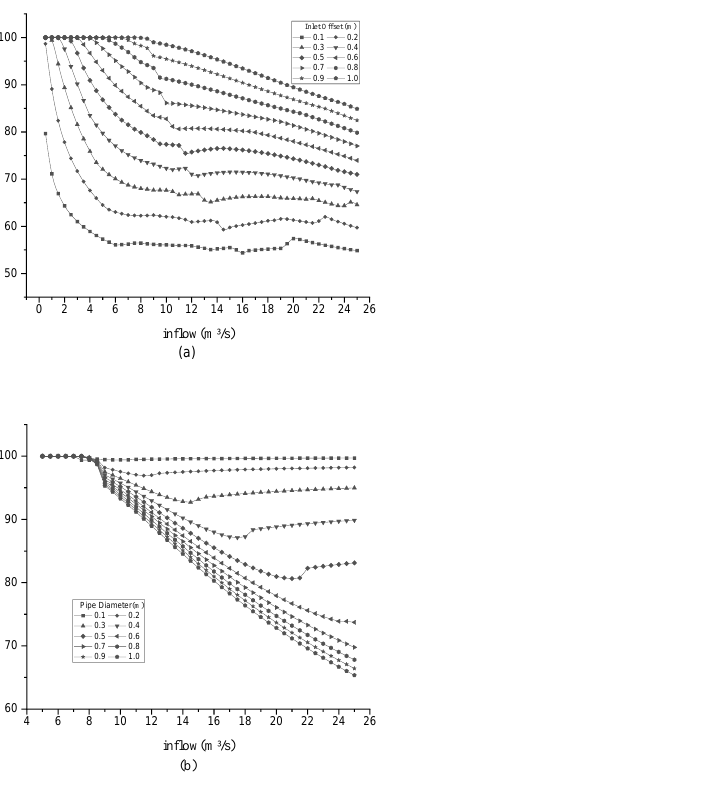
Figure 5. ( a ) Two pipelines with a diameter of 1 m. The inlet offset of one bifurcation pipe is constantly raised. ( b ) The diameter of one pipeline is 1 m, and the diameter of the other pipeline is increased above it.